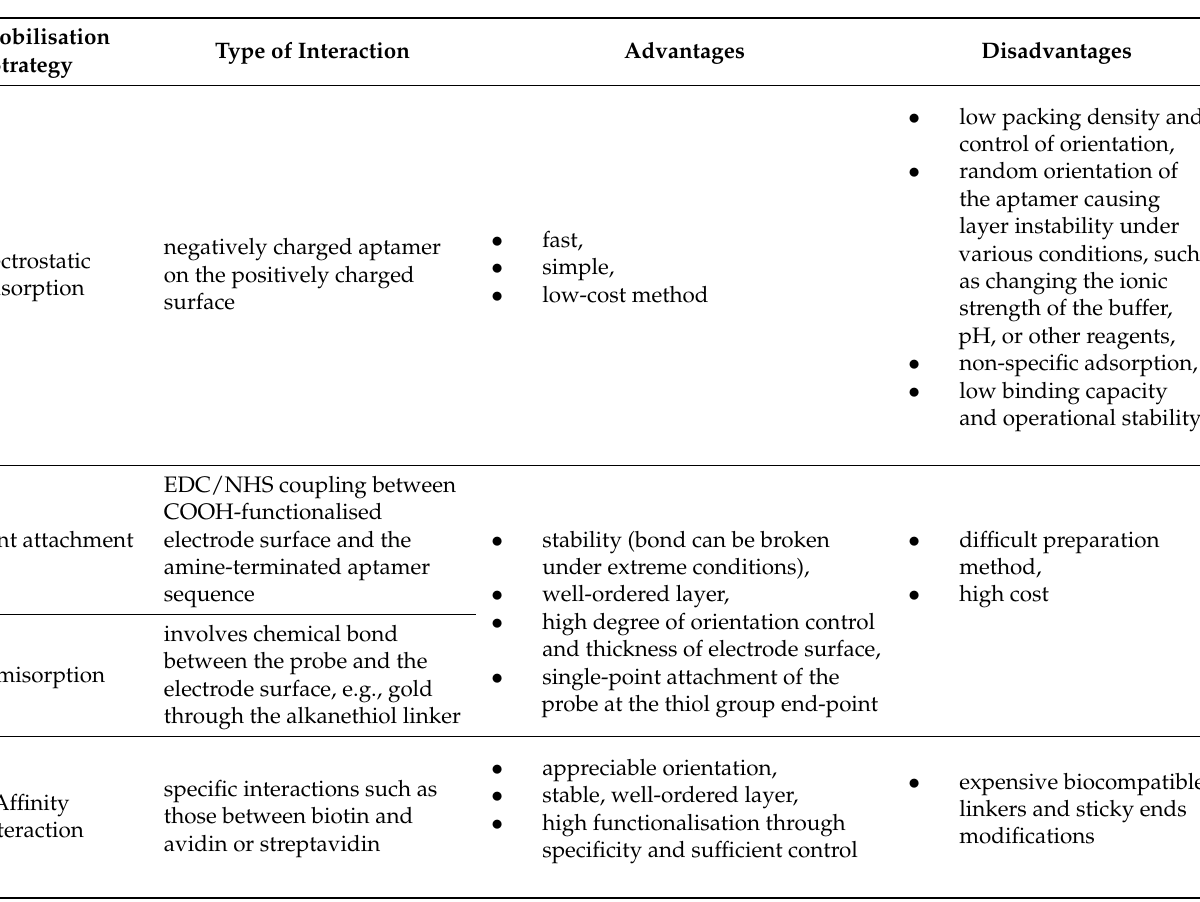
Table 1. Comparison of the methods of aptamers deposition on solid surfaces